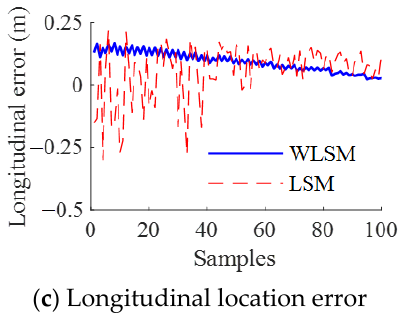
Figure 9 . Location results under condition ( b ). Figure 9. Location results under condition (b).